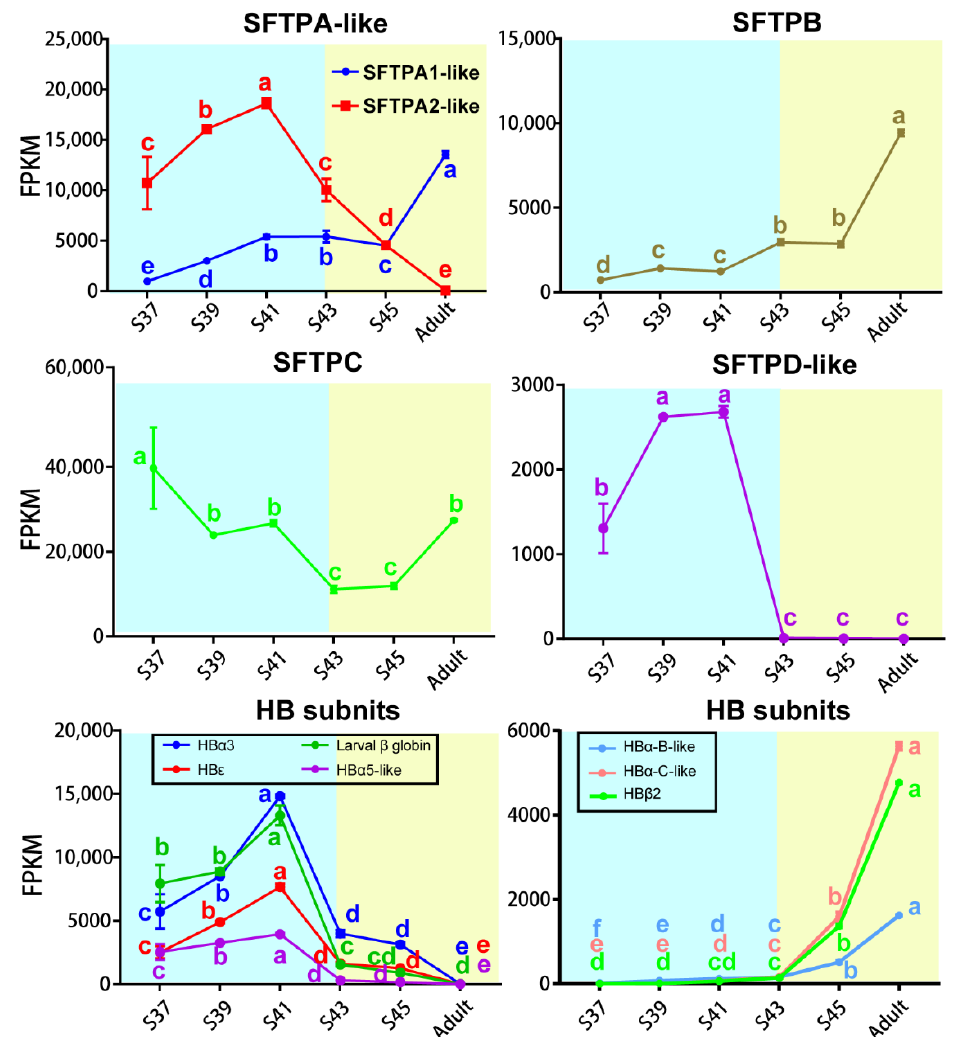
Figure 7. Transcriptional variation patterns of SFTPs and HBs subunits in the lung. Blue and yellow backgrounds represent the aquatic and terrestrial phases, respectively ( n = 3 each stage), Different letters denote significance between groups at a threshold of p < 0.05 (one-way ANOVA and S-N-K post-hoc test).